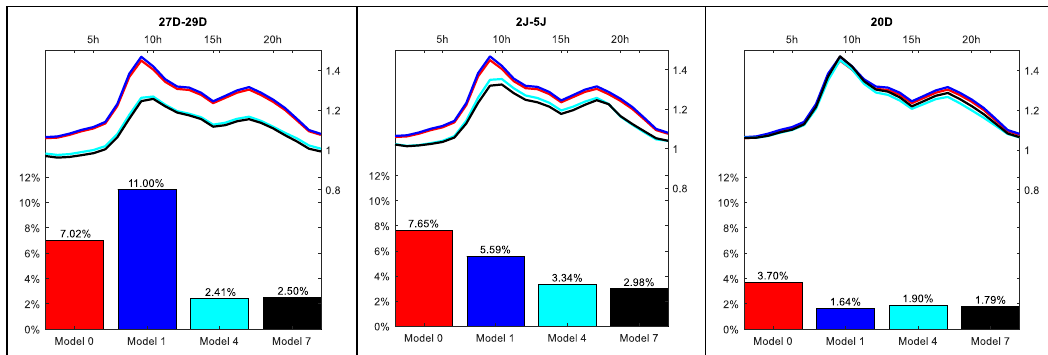
Figure A4. Regular holidays and days before and after.